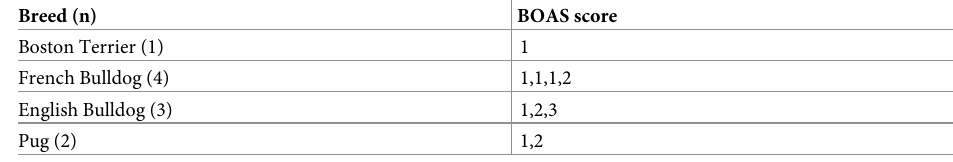
Pug (2) 1,2 Breeds and BOAS scores for dogs with clinical BOAS (scores 1–3). All dogs in the Mesa and Brachy groups had a score of